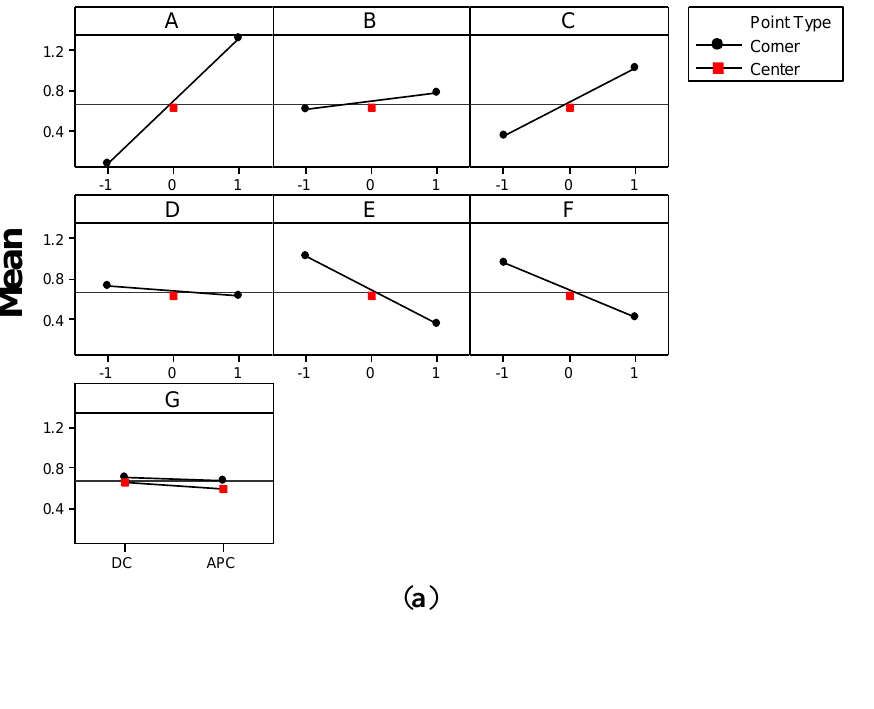
Figure 11. ( a ) Main effects; and ( b ) interaction plots for the effects on UED response. Solid lines represent low black levels (−1 and DC ) of the factors; dashed green lines represent high levels (1 and APC ); dashed red lines represent the center levels (0); left ends of the lines in each plot means low level of underlying factors, and the right ends depict the higher